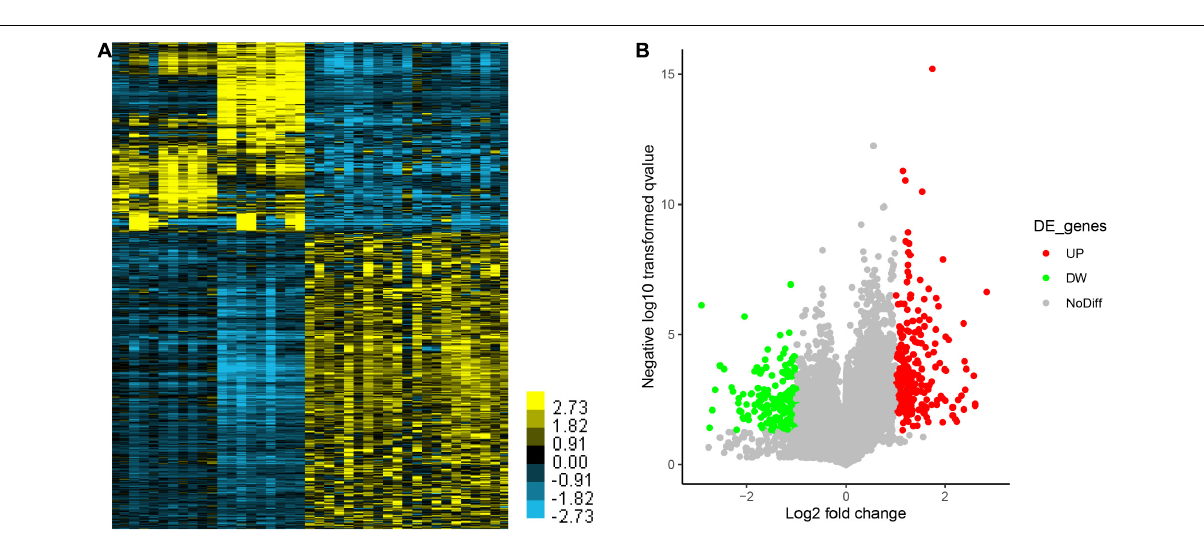
FIGURE 3 | Identification of differentially expressed genes (DEGs) between esophageal adenocarcinoma (EA) and esophageal squamous cell carcinoma (ESCC). (A,B) The differently expressed genes between EA and ESCC were shown using (A) Heatmap and (B) Volcano